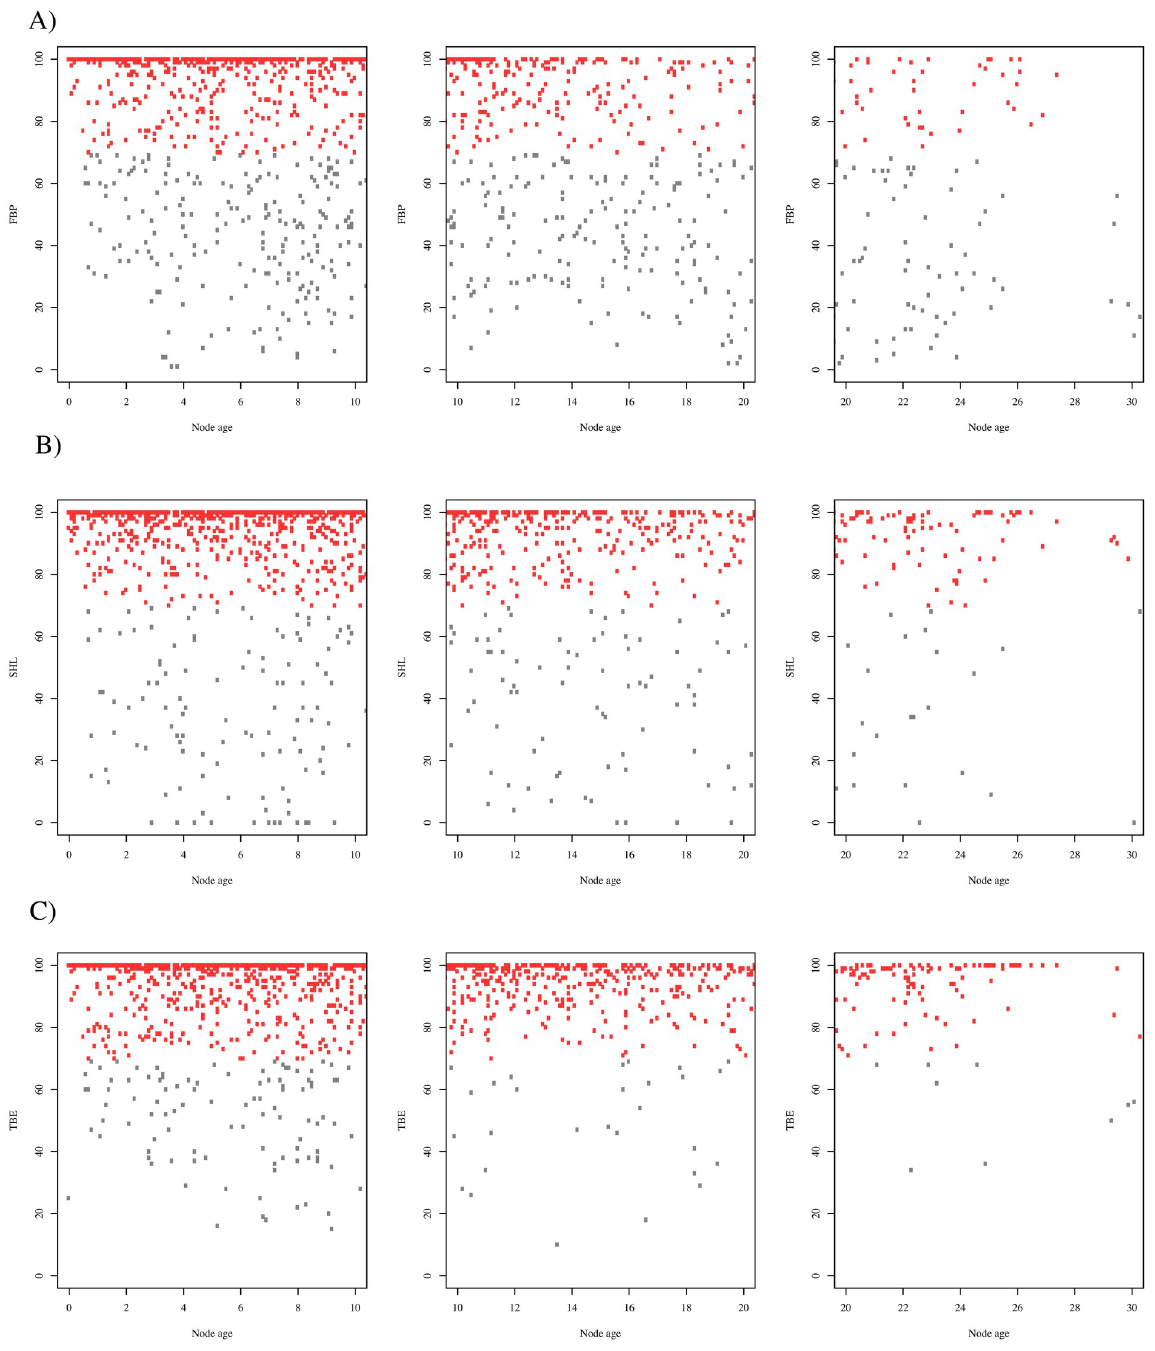
Fig 5. Distribution of branch support scores for each node age based on the Maximum likelihood species-level phylogeny of Colubroides. A) FBP distribution, B) SHL distribution, C) TBE distribution. Red dots represent values greater than 70%; gray dots indicate values smaller than